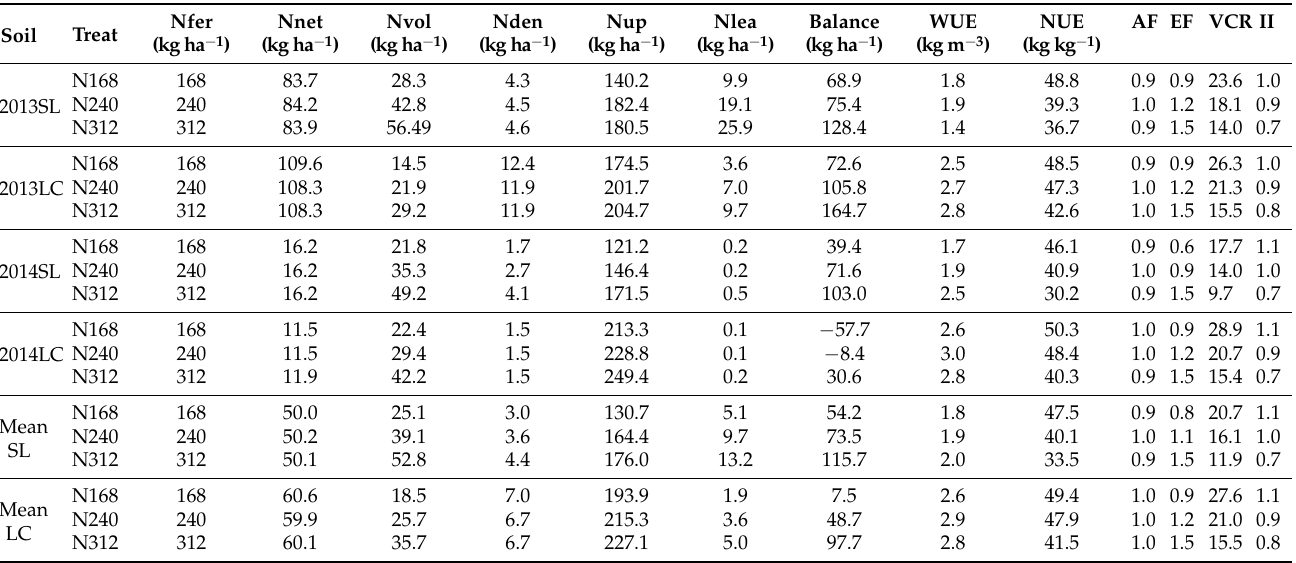
Table 3. N budgets, N-use efficiencies, and the integrated index under different N rates for two textural soils from 2013 to